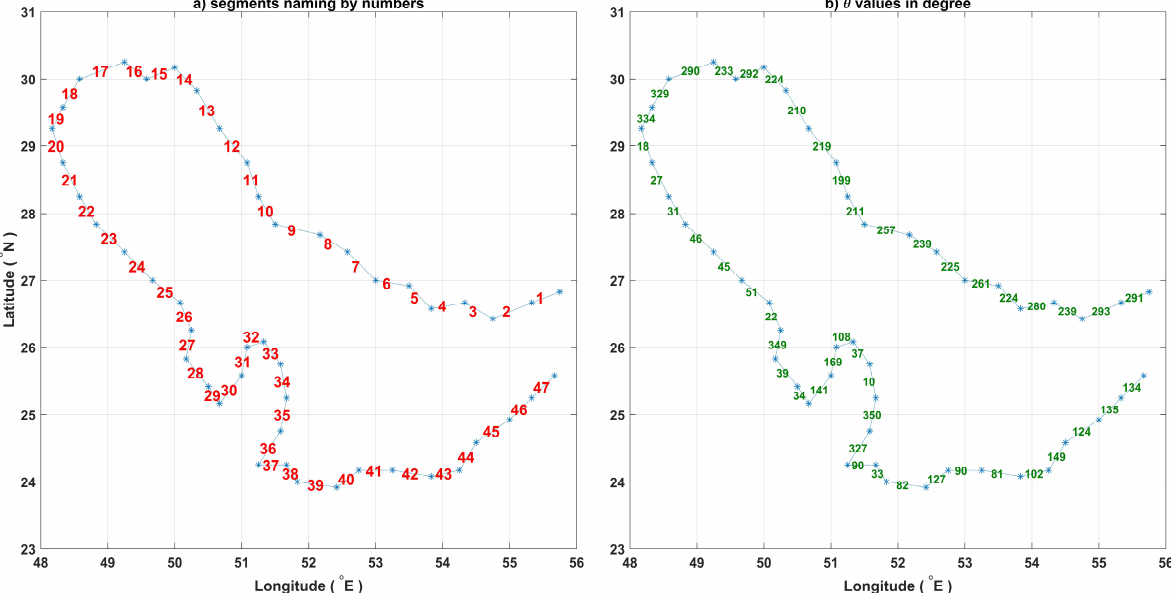
Figure 1. Segments named by numbers and the angle of θ corresponding to each segment (the location of each segment have shown by *).